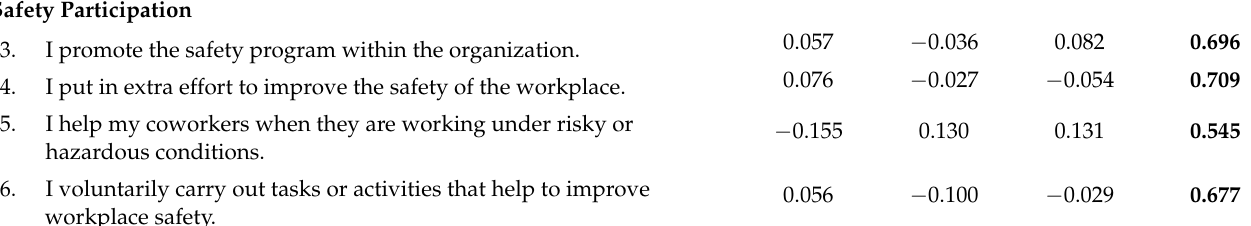
Factor Factor Factor 1 2 3